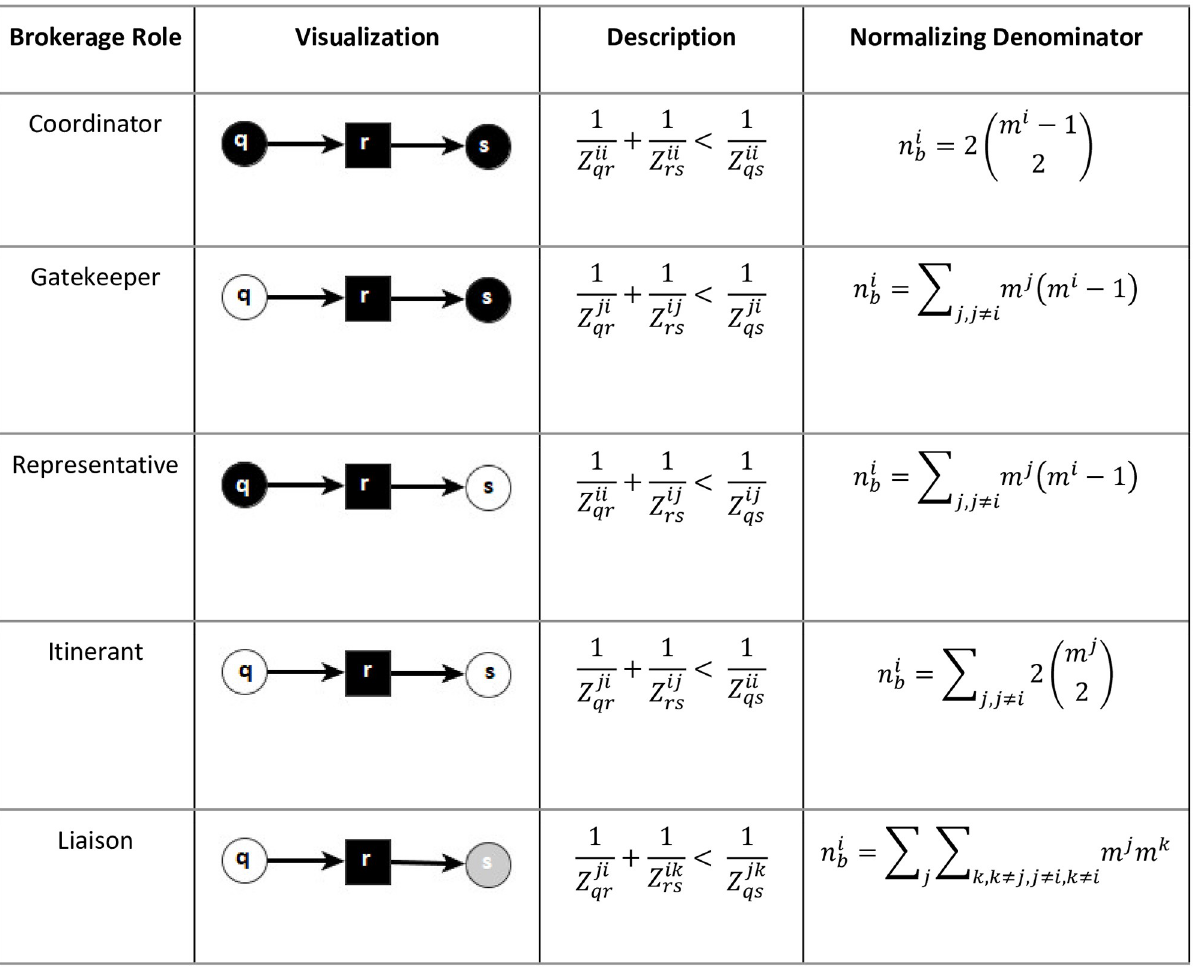
Fig 1. Visualization and description of GF brokerage roles. Note : The square is the broker , node color indicates group . Authors’ elaboration based on Gould and Fernandez [4].